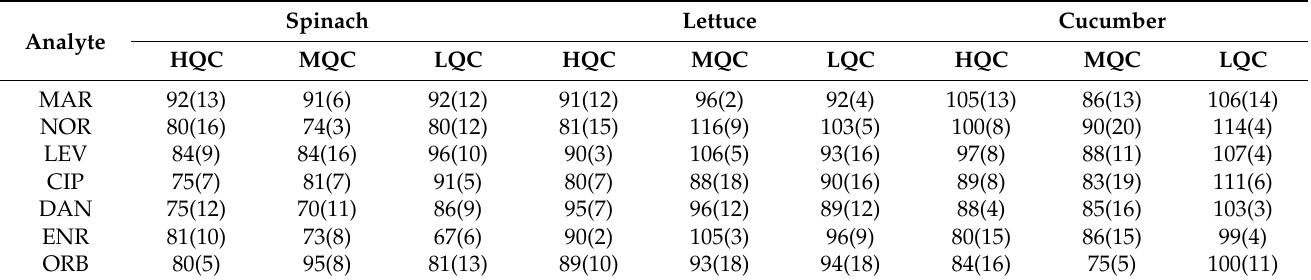
Table 1. Mean recovery values (% R, n = 3) with relative standard deviation (RSD%) in freeze-dried samples (spinach, lettuce and cucumber) spiked at three QC levels.